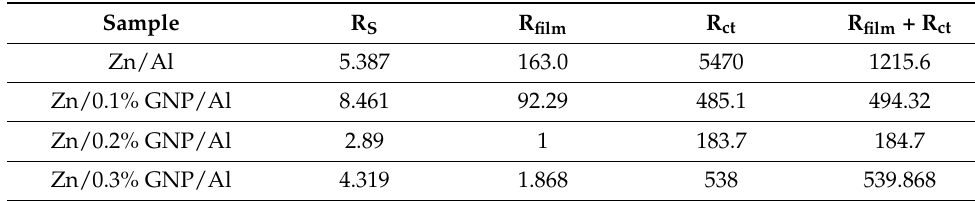
Table 1. Electrochemical resistance of Zn/Al and Zn/GNP/Al CS coatings. R ct is the mean charge transfer resistance at the coat/solution interface in parallel with the double-layer constant phase, R s is the solution resistance; and R film is the resistance of the coating in parallel with a constant phase element. The sum of R film and R ct is used to characterise corrosion resistance. Presented with permission from